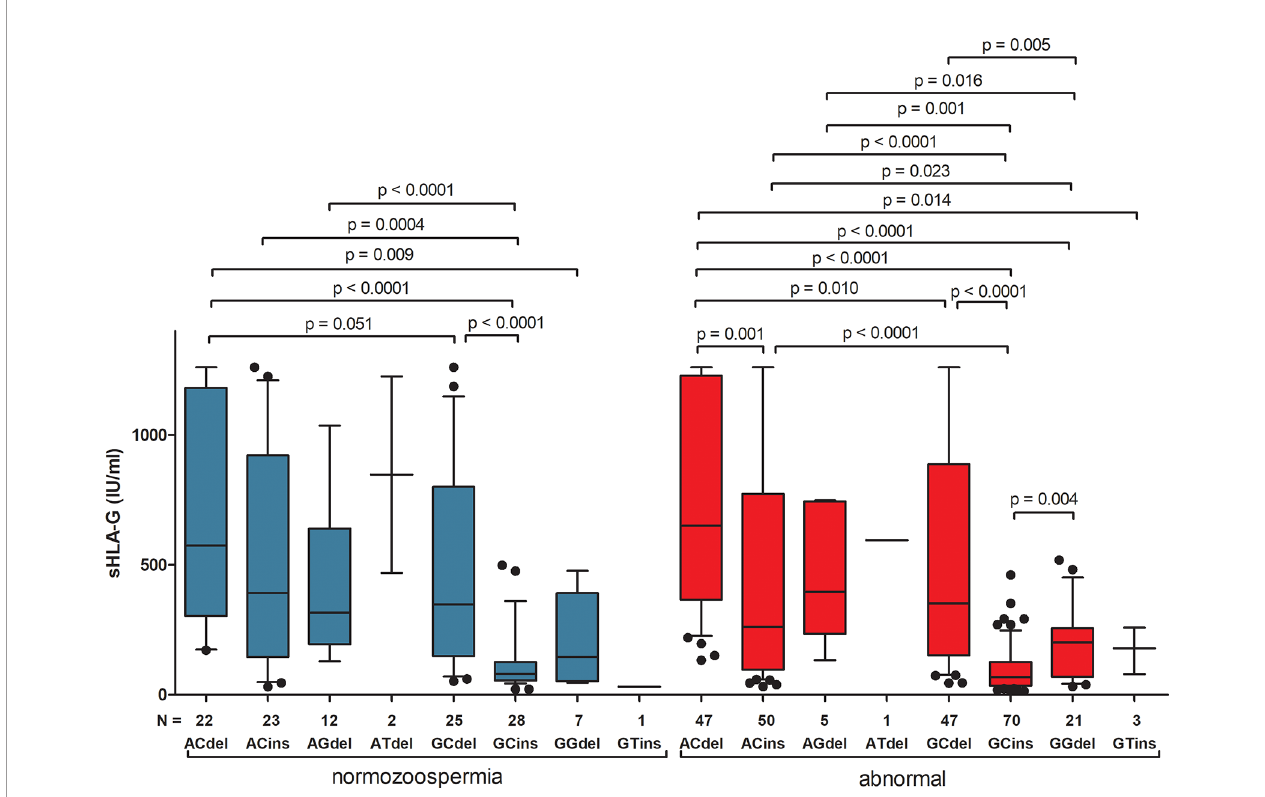
FIGURE 1 | Concentrationofsoluble HLA-G permilliliter ofplasma(IU/ml)measuredinsemensamples according to HLA-G haplotypes. Haplotypeswereestimatedinthe followingorder:rs1632947: − 964G>A; rs1233334: − 725G>C/T;rs371194629:insATTTGTTCATGCCT/del. Blueboxesrepresentthe levelofsHLA-Gmeasuredin normozoospermicmenandredboxes – inmenwithabnormalsemenparameters.Boxesaredrawnfrom the fi rstquartile(25thPercentile) to thethirdquartile(75thPercentile). Blacklinesinboxesaremedians. Whiskersrepresent10-90percentiles.Nisthe numberofpatients. P-valuesarecalculatedbyMann-Whitneytestor